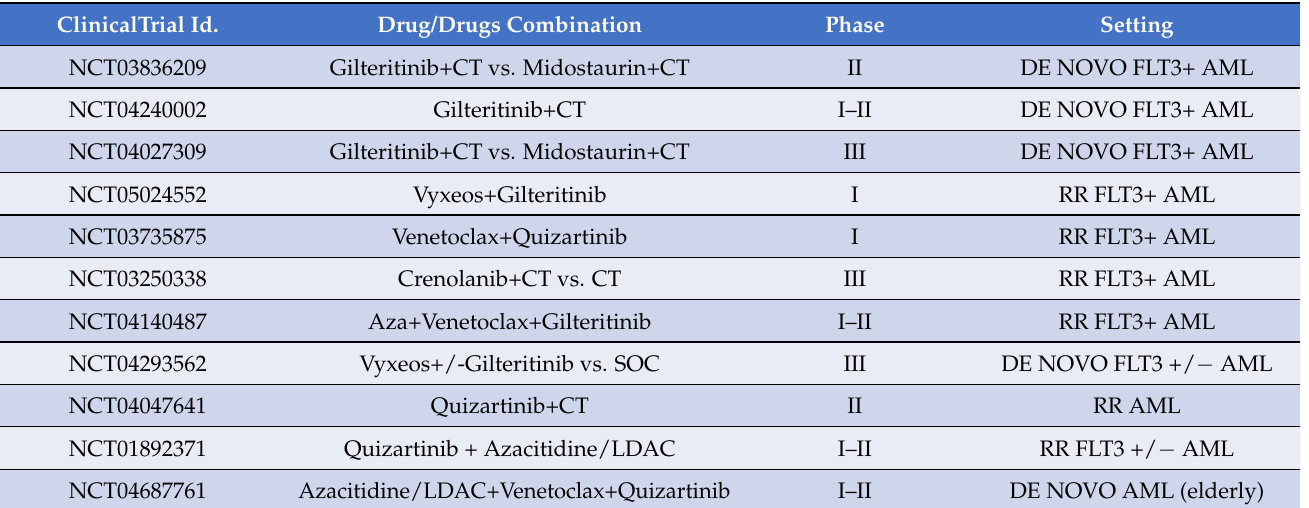
Table 5. List of ongoing clinical trials including chemotherapy or Hypomethylating agents and- FLT3i.